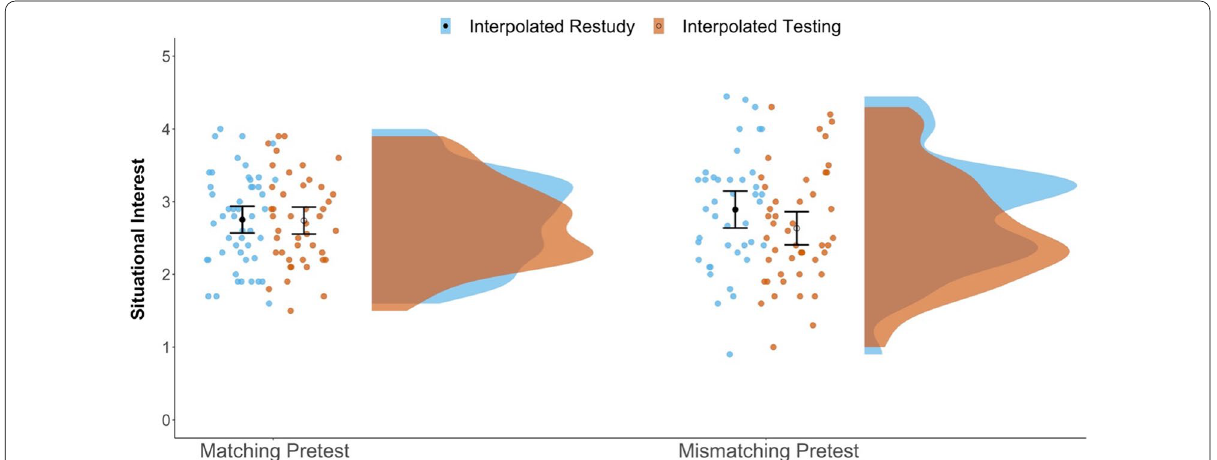
Fig. 7 Raincloud plots depicting differences in situational interest ratings between conditions. Dots represent individual subject means in each condition. The closed black dots represent group-level mean estimates for the Restudy conditions; open circles represent the group-level mean estimates for the Testing conditions. Error bars are 95% confidence